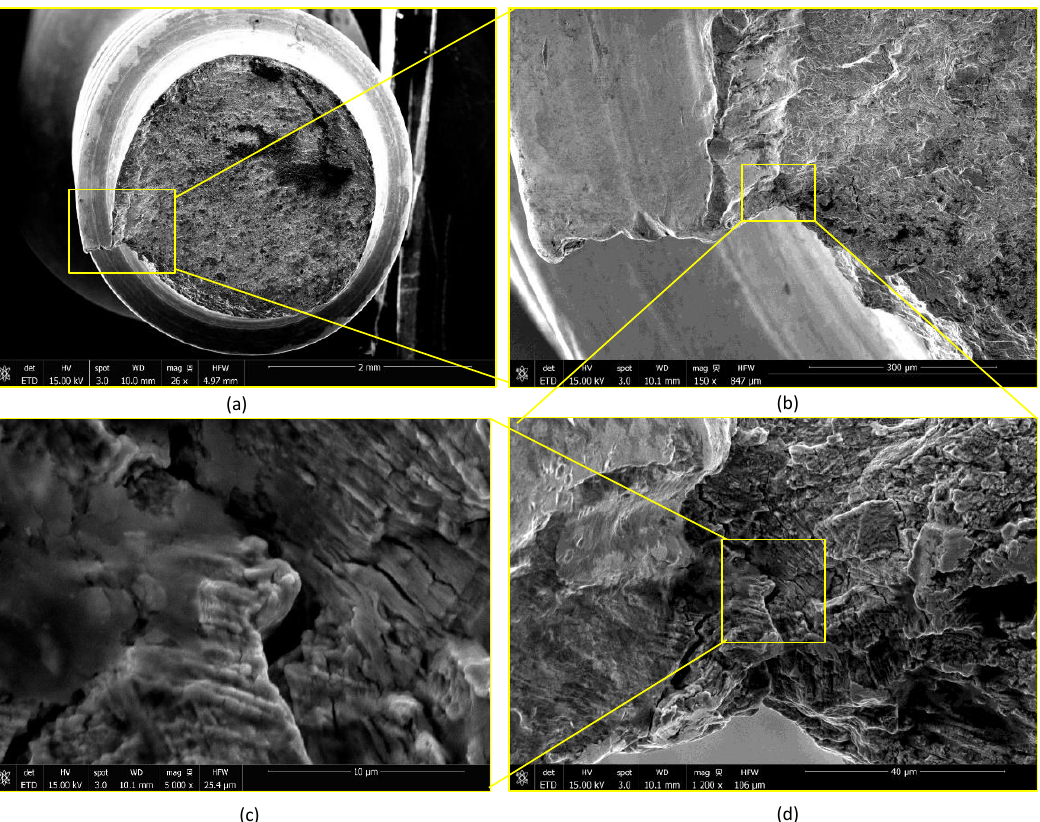
Figure A8. ( a ) Fracture surface of the cortical screw (CS1) and ( b , c ) mechanical damage caused by scratching the other side after failure.